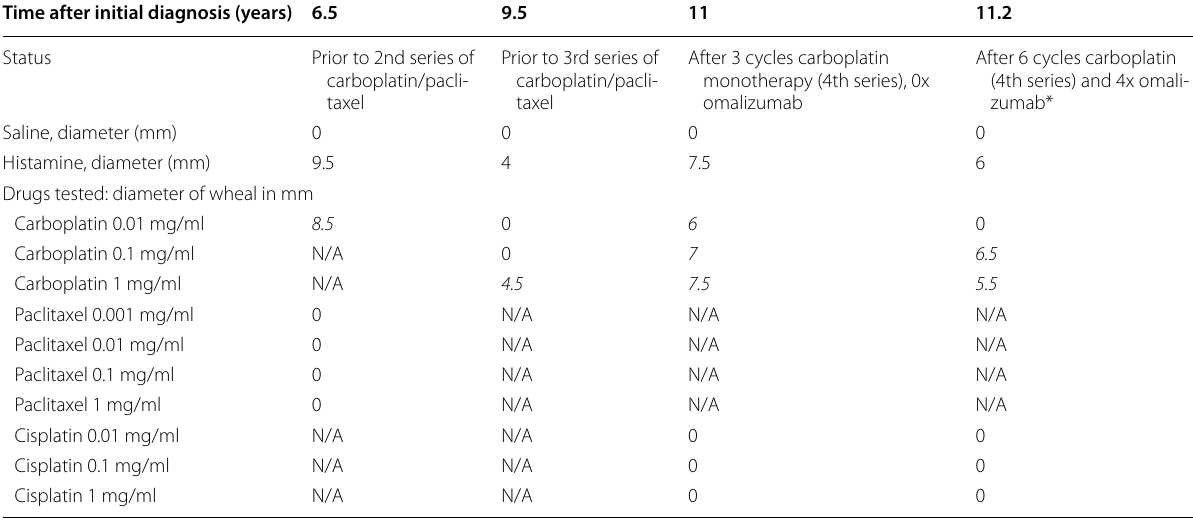
Table 2 Diagnostic testing in suspected carboplatin